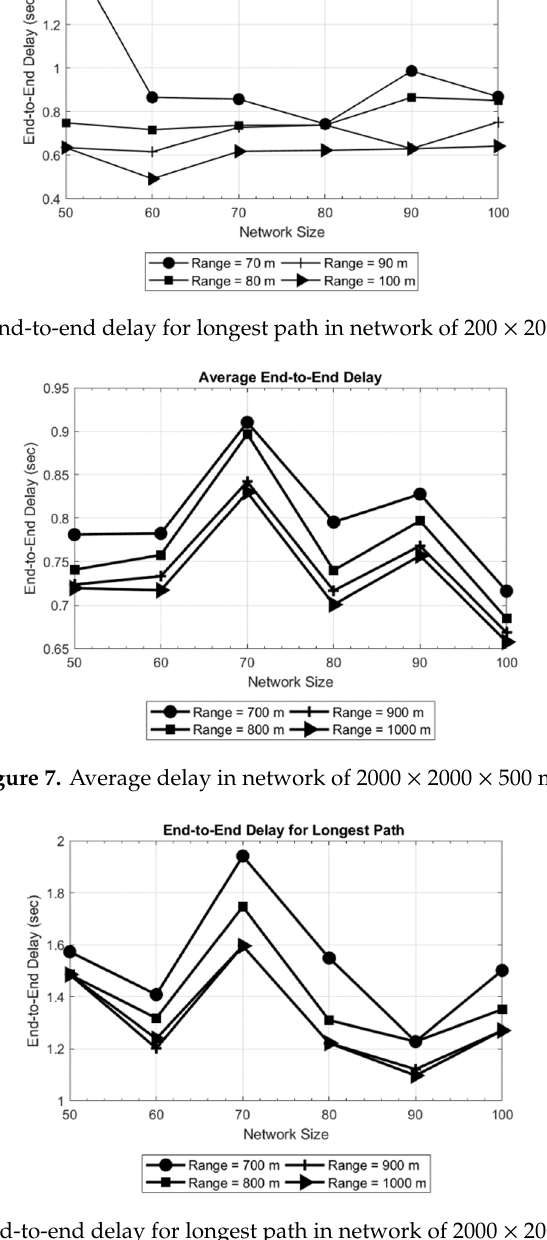
Figure 8. End-to-end delay for longest path in network of 2000 × 2000 × 500 m .